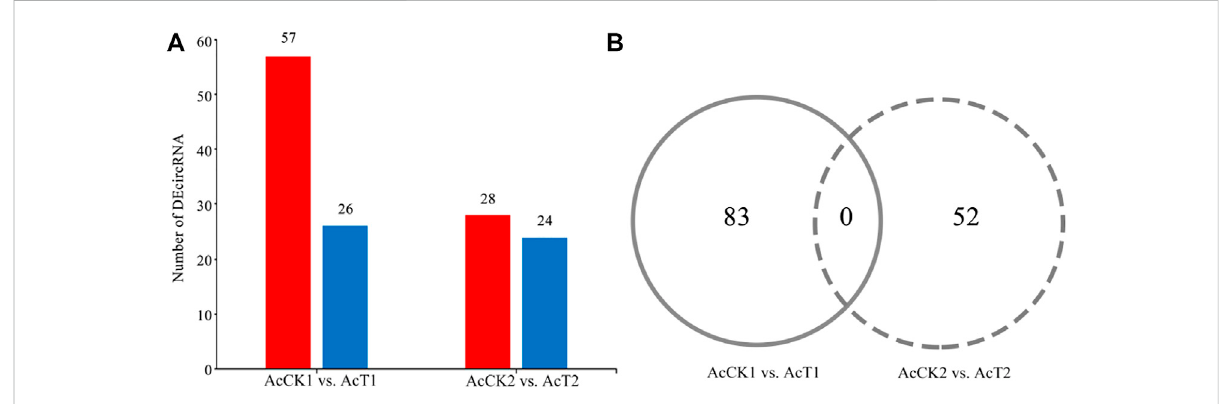
FIGURE 3 Number statistics of DEcircRNAs in AcCK1 vs. AcT1 and AcCK2 vs. AcT2 comparison groups. (A) Number of up- and down-regulated circRNAs (B) Venn analysis of